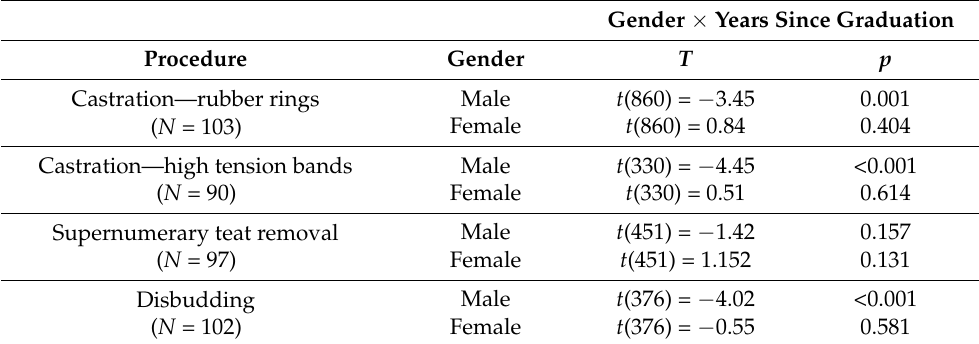
Table 5. The interaction effect between gender and years since graduation on the perceived pain scores a of veterinarians across certain husbandry procedures.